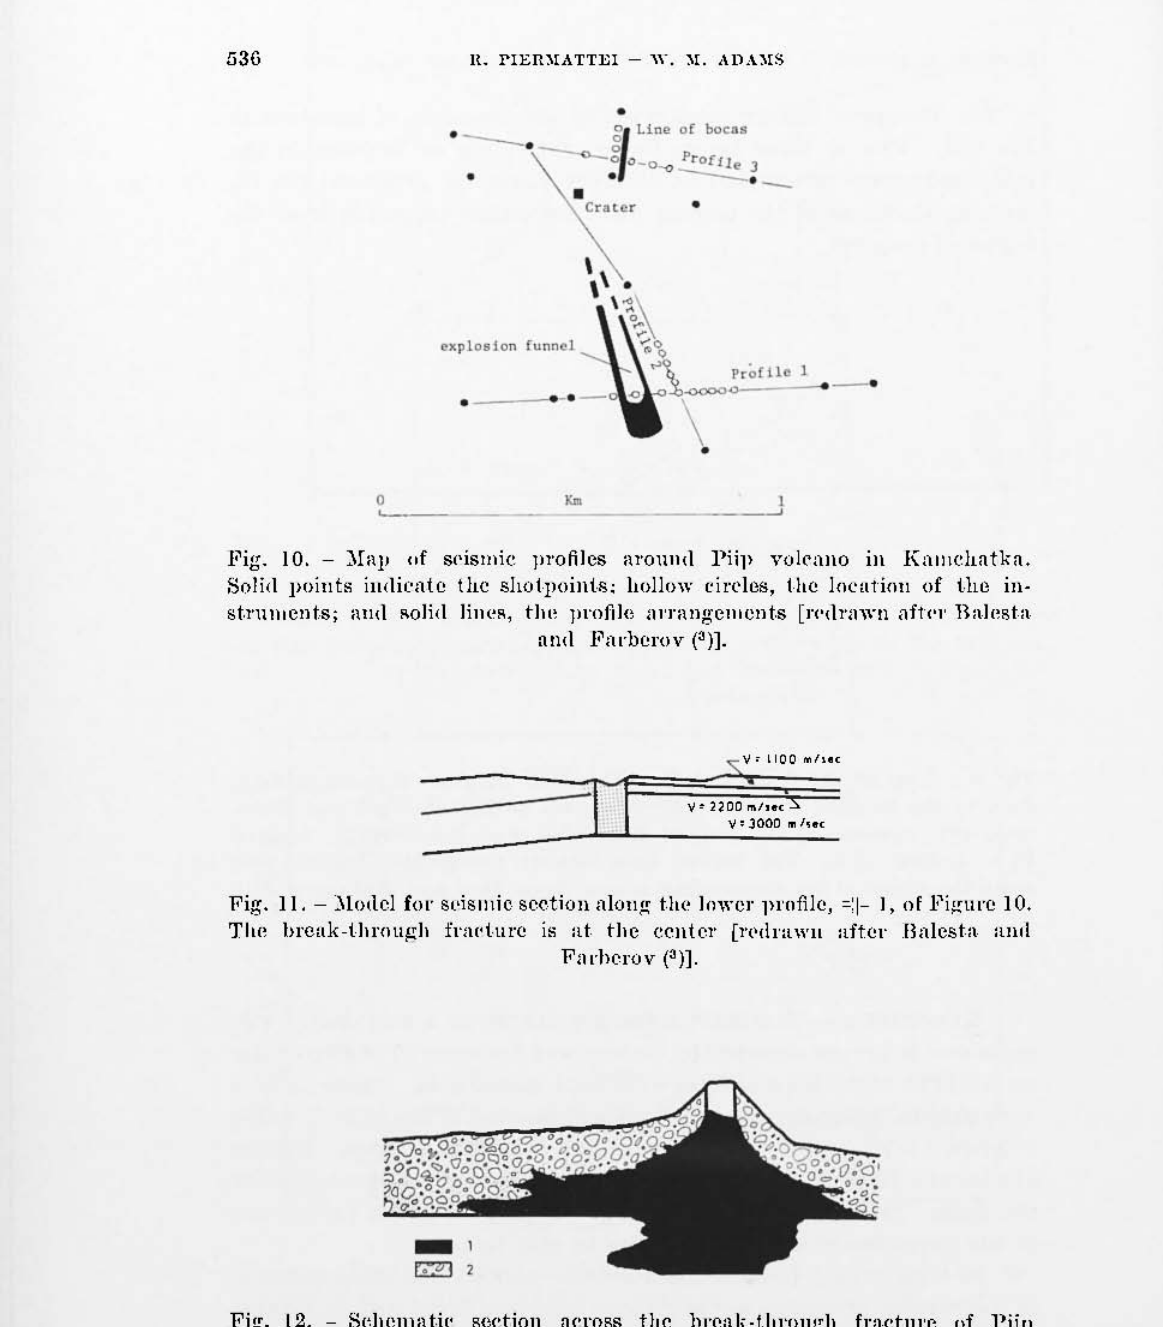
Fig-. 12. SdICmatil' s(wtioll a('mss tltc break.tlmJUgh fr:Wt11!"C of Piip Yo\eallo. Thc eentral llInl.crial (I) is injc('h~11 lava. S11lT011111Iell on botli si(lcs by l'.rro("la~(i(" material (2) [rellraW11 after Balesta al1(l Jo'al'herov